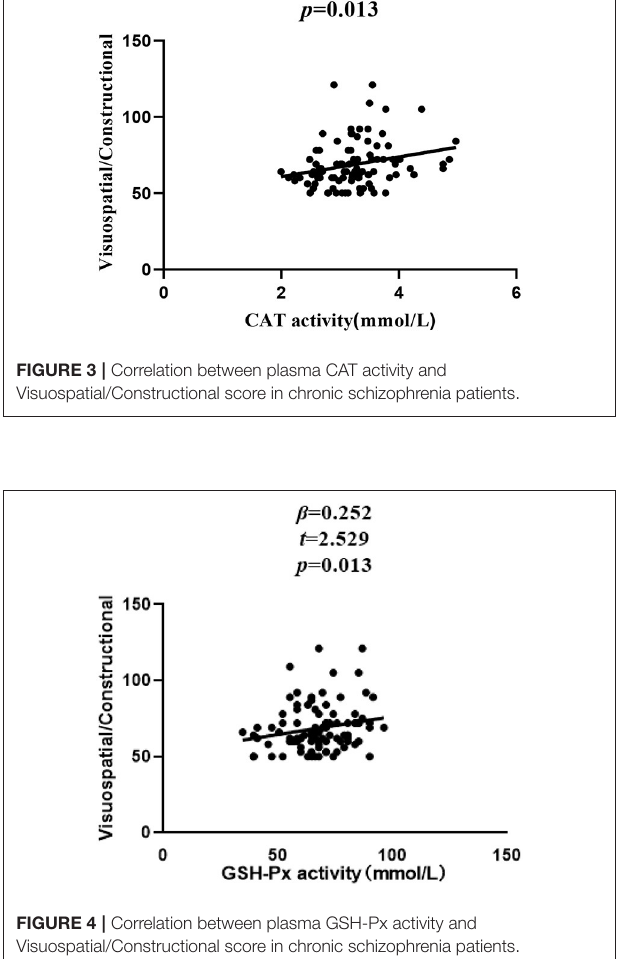
Further, stepwise multiple regression analysis that CAT ∗ GSH- Px ( β = 0.324, t = 3.321, P = 0.001; Figure 2 ), CAT ( β = 0.252, t = 2.529, P = 0.013; Figure 3 ) and GSH-Px ( β = 0.211, t